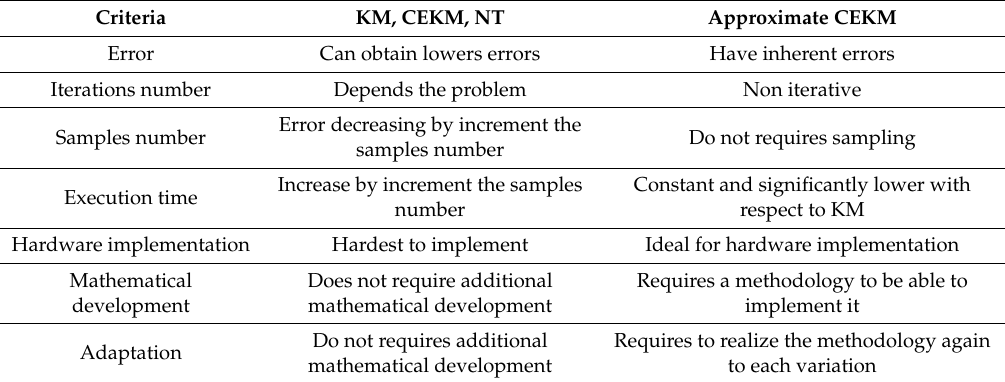
Table 17. Advantages and Disadvantages of the Approximate CEKM